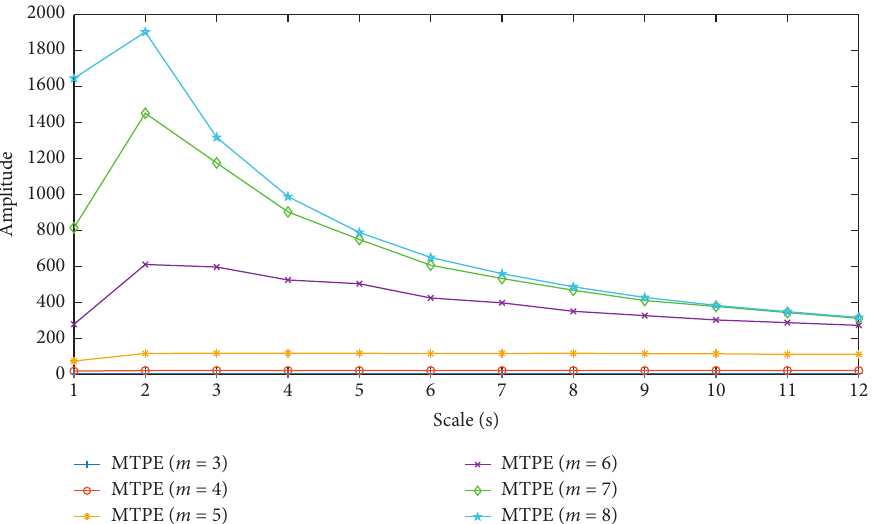
Figure 4: Effects of embedding dimension m on